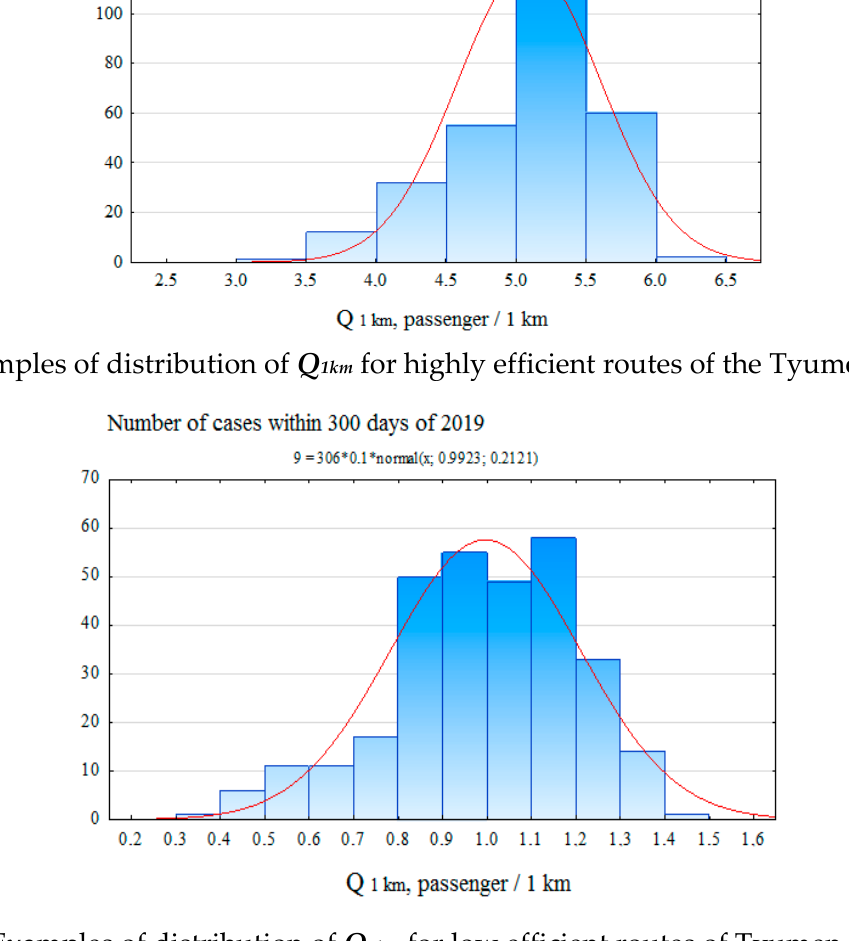
Figure 2. Differentiation of quality and efficiency of passenger transportation on the Tyumen CPPT bus routing network. Note: highly efficient routes serve the city center; low efficient routes serve remote city areas and the suburbs.